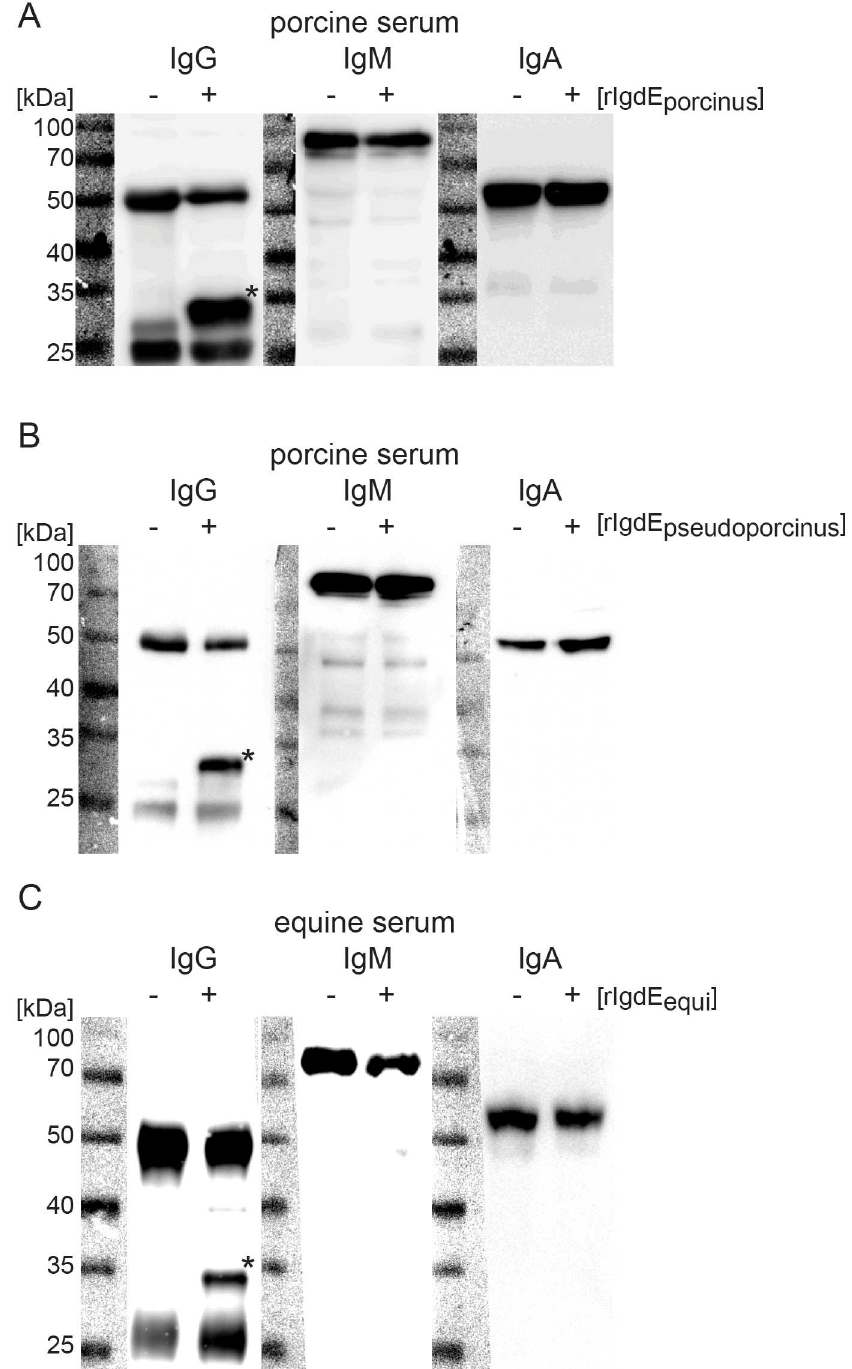
Fig 3. IgdE family proteases are specific for IgG compared to IgM and IgA. 2% porcine plasma was incubatedwith (+) or without (-) 20 μ g/ml purified rIgdE porcinus (A) or 5% soluble fraction of E. coli cells expressing rIgdE pseudoporcinus (B) respectivelyfor 16h at 37˚C. 2% equineserum was incubatedwith 5% solublefraction of E. coli cells expressing rIgdE equi (C) for 16h at 37˚C. The reactions were analyzedby anti- porcineor anti-equineIgG, IgM and IgA Western blots under reducing conditions. Only degradationproducts of IgG ( * ) could be